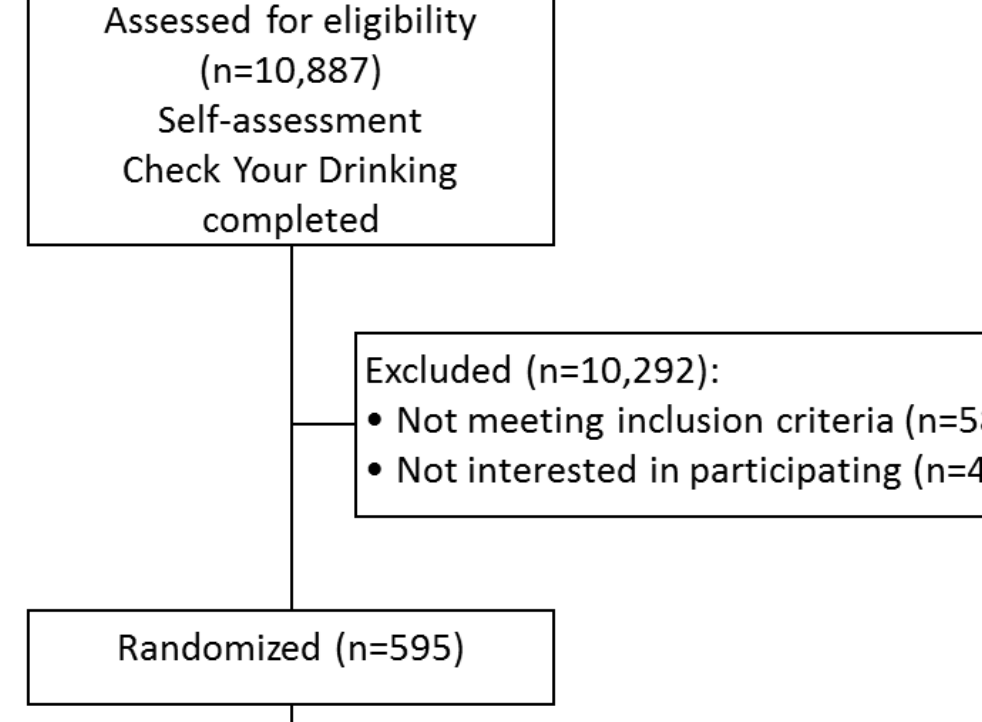
Figure 2. CONSORT flow diagram of